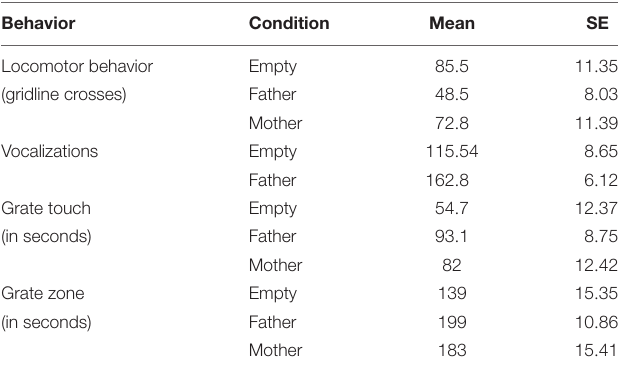
TABLE 2 | Mean and standard errors for our 25 subjects’ behavior across all 3 days of IOF testing.